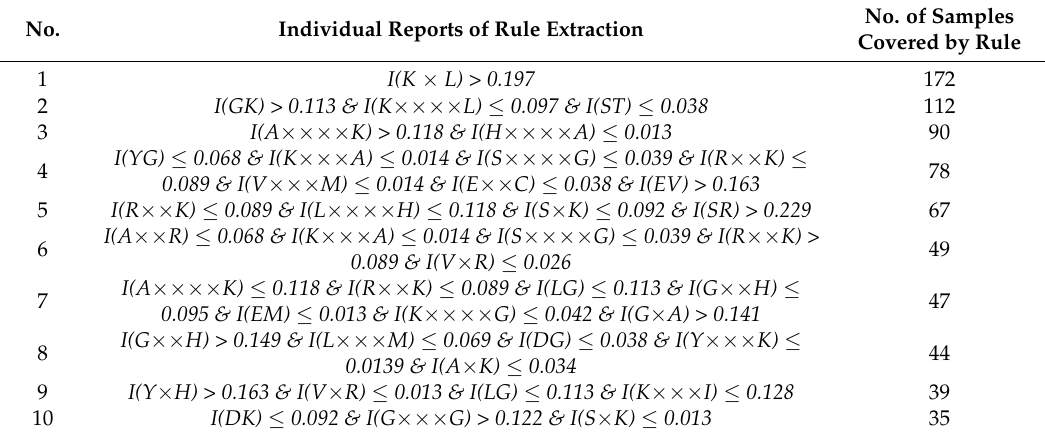
Table 4. The extracted rules collected from NTyroSite model.